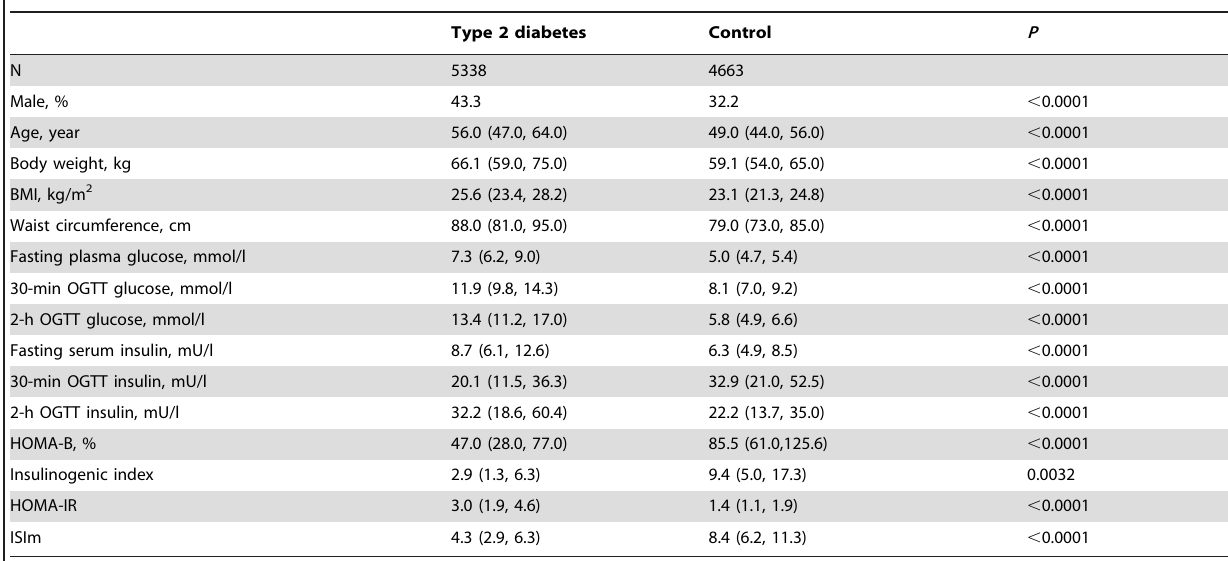
Table 1. Clinical characteristics of study